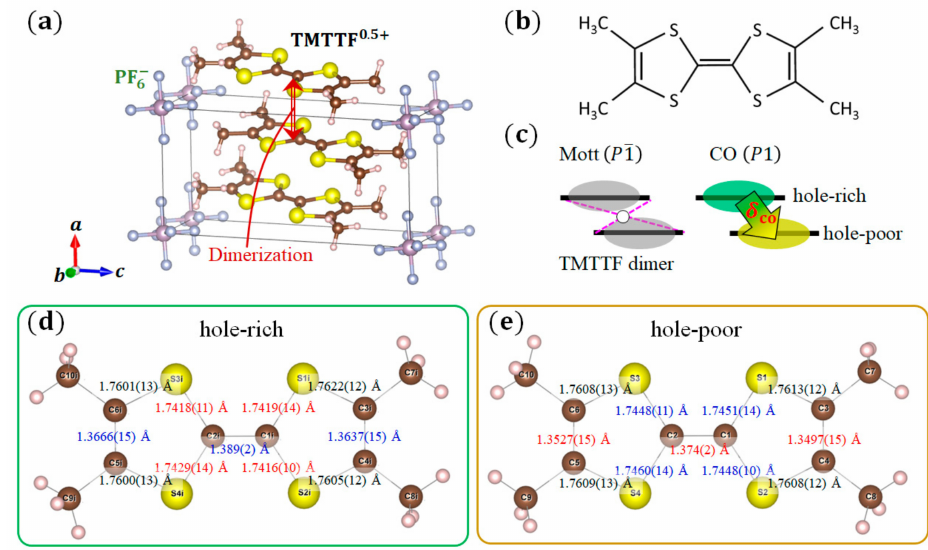
Figure 6. ( a ) Crystal structure of (TMTTF) 2 PF 6 ; ( b ) Molecular structure of a TMTTF; ( c ) Schematic configuration of the dimer Mott and charge ordering (CO) phases; ( d , e ) Bond length in the ( d ) hole-rich and ( e ) hole-poor TMTTF molecules at 30 K in the charge ordering phase of (TMTTF) 2 PF 6 . The red (blue) values indicate that the bonds are shorter (longer) than the others at the same positions. The black values indicate that bonds at the same position are consistent within the error